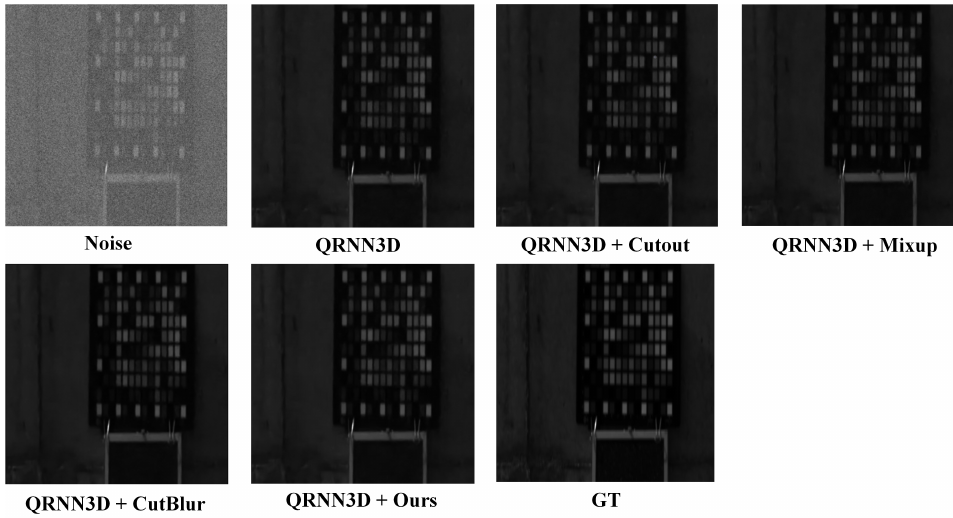
Figure 5. We chose band 25 for comparison with other DA